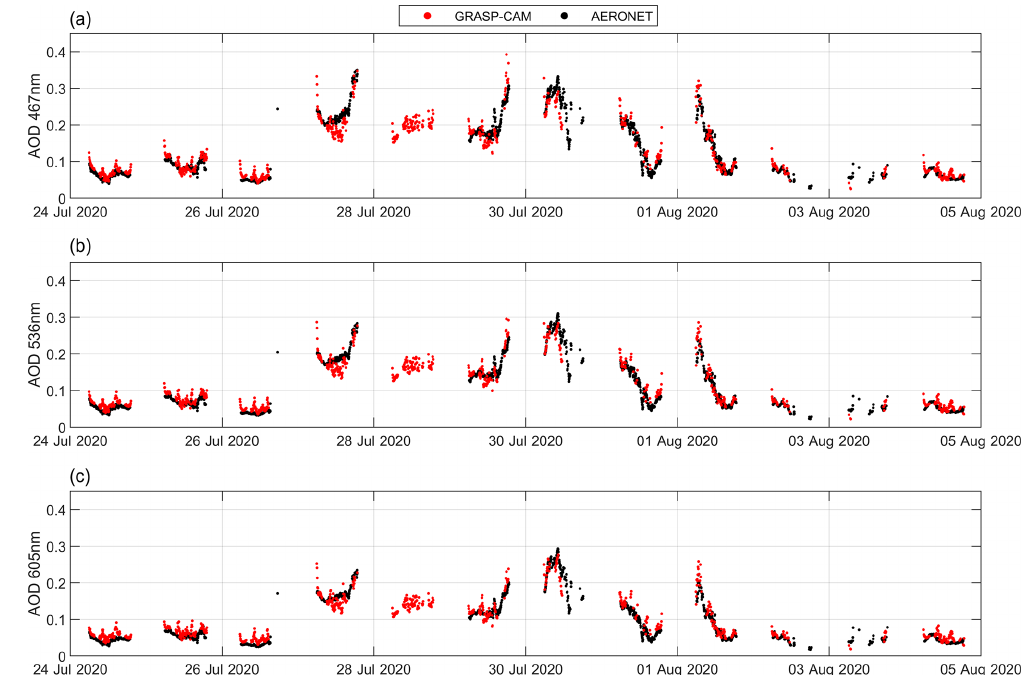
Figure 8. Aerosol optical depth (AOD) at 467nm (a) , 536nm (b) and 605nm (c) retrieved by GRASP with the single-pixel approach (GRASP-CAM) and by AERONET at Valladolid from 24 July to 4 August 2020. AERONET data have been interpolated to the all-sky camera wavelengths.